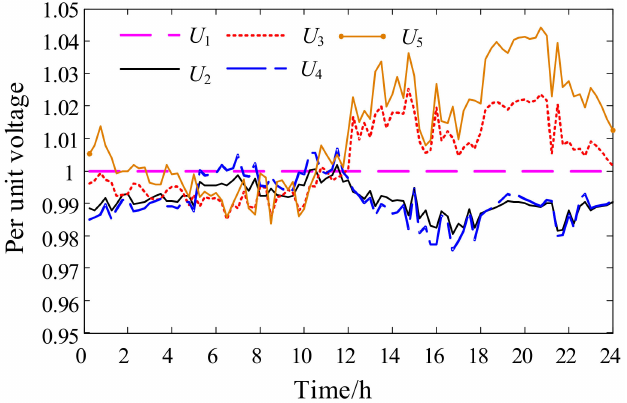
Figure 11. Voltage of energy stations in the IES.